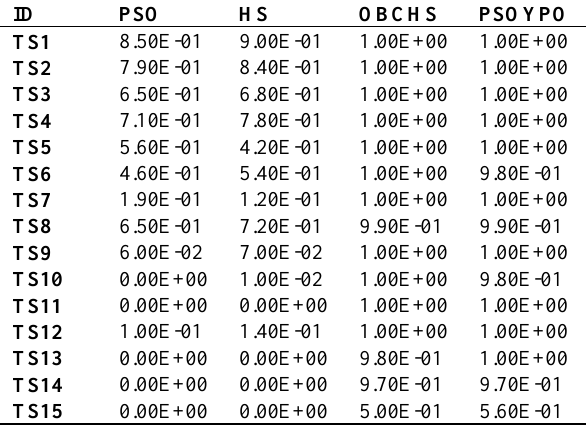
Table 3. Comparison of HR values